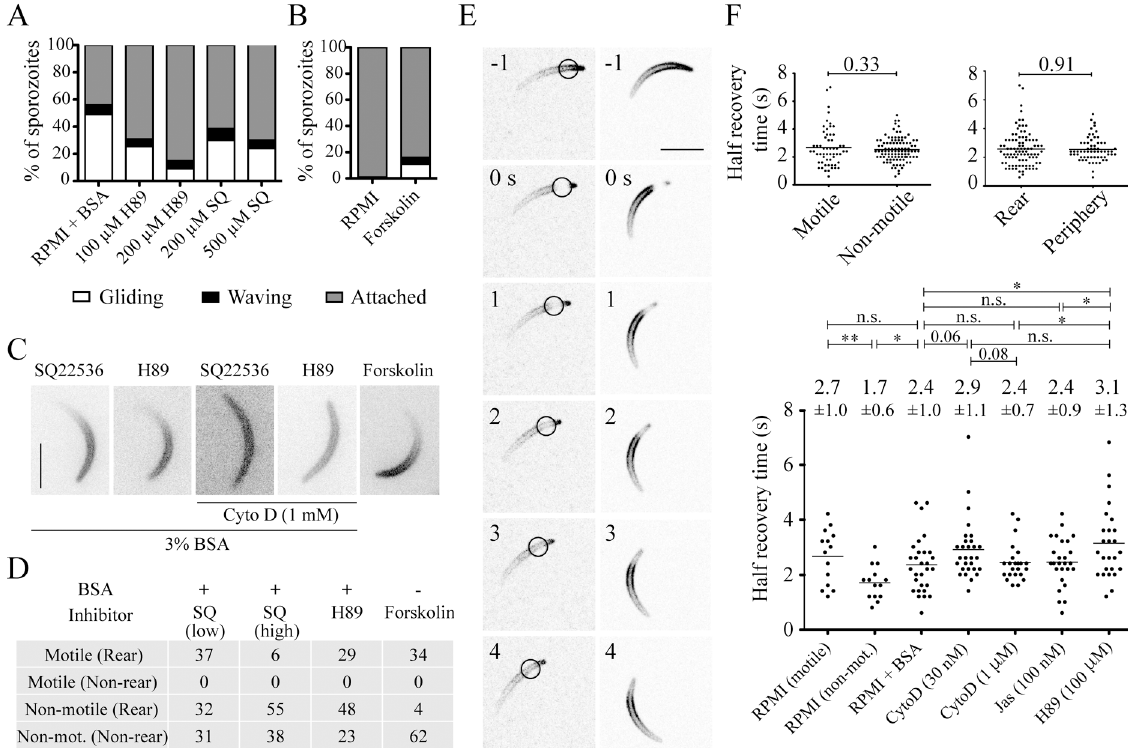
Fig 5. cAMP signaling downstream of coronin relocalization modulates motility. (A) Sporozoites were incubated in RPMI + 3% BSA with the indicated kinase inhibitors at the indicated concentrations, imaged and their movement pattern quantified as gliding, waving or attached. The inhibitors stopped sporozoite motility in a dose-dependent fashion. Over 150 sporozoites were examined for each experiment. Significant differences (Fisher ’ s exact test) from the controls show both concentrations of H89 tested (p < 0.0001) as well as 500 μ M SQ22536 (SQ) (p = 0.01; p = 0.46 for 200 μ M SQ22536). (B) Forskolin partially stimulates sporozoite motility when added to sporozoites in RPMI. Over 300 sporozoites were examined and their motility pattern quantified as in A. The shown difference is significant (p < 0.0001; Fisher ’ s exact test). (C) Coronin-mCherry expressing sporozoites were investigated under various kinase inhibitors (each at 0,1 mM) with a fluorescence microscope to determine coronin-mCherry localization. The fluorescence stays at the rear in activated sporozoites arrested with PKA inhibitors. Coronin-mCherry relocalizes to the periphery when additional cytochalasin D is applied. Addition of forskolin to non-activated sporozoites leads to the localization of coronin-mCherry to the rear. Scale bar: 5 μ m. (D) Table showing percentages of motile and non-motile sporozoites and the associated localization patterns (rear versus non-rear) of coronin-mCherry under the indicated conditions; low and high concentrations of SQ22536 (SQ) were 0,1 and 0,5 mM, respectively. Between 105 and 120 sporozoites were examined per condition. Statistical differences determined by Fisher ’ s exact test was p < 0.0001 from the respective controls listed in the table of Fig 4A. (E) Examples of FRAP of motile sporozoites with coronin-mCherry localized to the rear. Scale bar: 5 μ m. Circle indicates location of the bleach spot. (F) Quantitative analysis of FRAP. Coronin-mCherry recovers as fast in motile ( > 0.25 μ m/s) as in non- motile ( < 0.25 μ m/s) sporozoites if pooled across all conditions. There is also no difference in recovery time depending on the localization of coronin-mCherry [top graphs]. Quantitative analysis of FRAP data over a range of conditions [bottom graph]. Average values (+/- S.D.) are indicated above the graph. Bars show significant differences ( * p < 0.05; ** p < 0.01), non-significance (ns) or p-values (Students t-test). Coronin-mCherry recovers significantly faster in non-motile sporozoites incubated in RPMI than in any other condition. With all other conditions there is no difference from each other with the exception of H89, where coronin- mCherry recovers significantly slower when compared to controls, 1 μ M Cytochalasin D and 100 nM Jasplakinolide